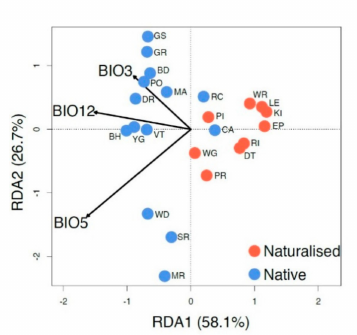
Figure 5. Redundancy analysis with the mean annual precipitation (BIO12), maximum temperature